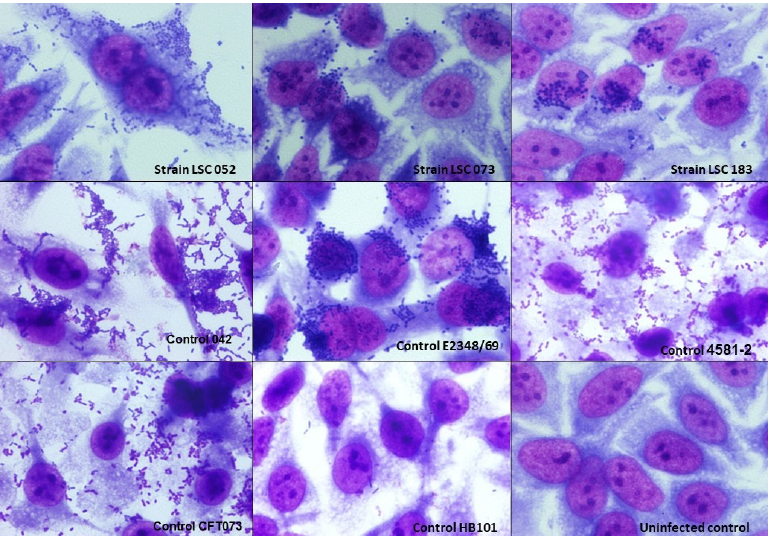
Figure 1. Adherence patterns of hybrid uropathogenic Escherichia coli (UPEC) strains to HeLa cells. Adherence patterns were evaluated in assays with incubation periods of 3 h or 6 h, at 37 ◦ C, in the presence of 2% D-mannose, using a multiplicity of infection of 10. The preparations were stained with May-Grünwald/Giemsa and observed under an optical microscope (magnification × 1000). All hybrid UPEC strains were adherent. Strain LSC 052, showing the aggregative adherence (AA) pattern; strains LSC 073 and LSC 183, showing the localized adherence-like (LAL) pattern. E. coli strains used as controls: 042 (prototype enteroaggregative E. coli (EAEC) expressing AA; E2348/69 (prototype typical enteropathogenic E. coli (EPEC) expressing a localized adherence (LA) pattern); 4581-2 (atypical EPEC (aEPEC) showing the LAL pattern); CFT073 (prototype UPEC strain); HB101 ( E. coli K-12-derived laboratory strain, non-adherent).